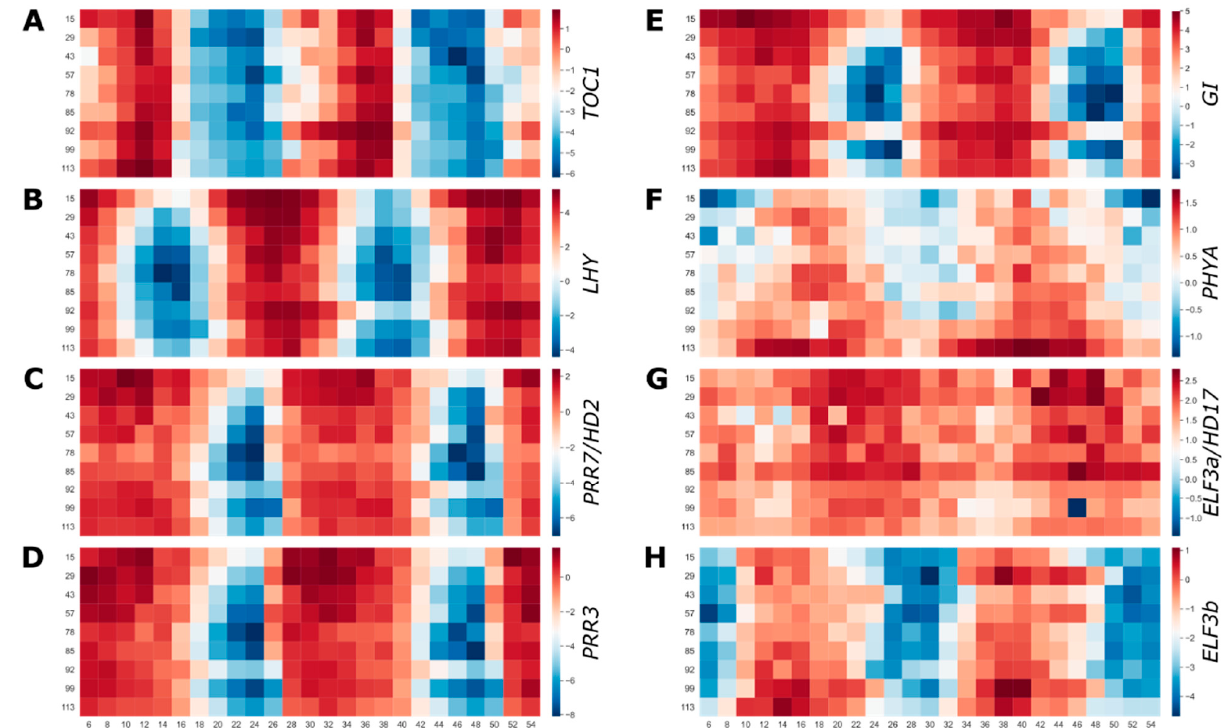
Figure 3. Core circadian clock, light and flowering genes across the developmental time course. Gene expression across the developmental time course in leaves for ( A ) TIMING of CAB EXPRE- SION 1 ( TOC1 )/ Pseudo-response regulator 1 ( PRR1 ); ( B ) LATE ELONGATED HYPOCOTYL ( LHY ); ( C ) PRR7/HEADING DATE 2 ( HD2 ); ( D ) PRR3 ; ( E ) GIGANTEA ( GI ); ( F ) PHYTOCHROME A ( PHYA );